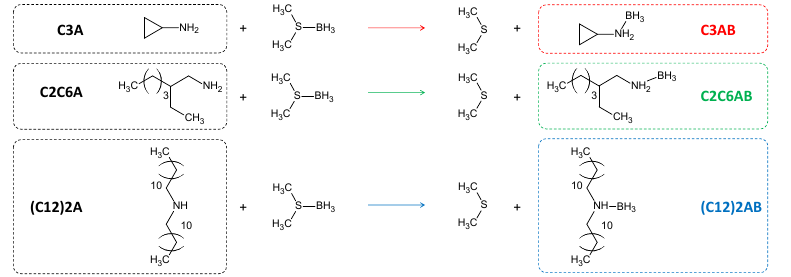
Figure 1. Reaction path for the synthesis of the ABAs in diethyl ether, under argon atmosphere and at ambient temperature: C3AB for cyclopropylamine borane C2C6AB for 2 ‐ ethyl ‐ 1 ‐ hexylamine bo ‐ rane, and (C12)2AB for didodecylamine borane. 2. Results and Discussion 2.1. Syntheses of the ABAs Driven by Calvet Calorimetry The amines C3A, C2C6A or (C12)2A readily react with (CH 3 ) 2 S ∙ BH 3 . We determined the enthalpies of reaction by Calvet calorimetry (Figure 2). They are of − 40.8, − 39 and − 56.3